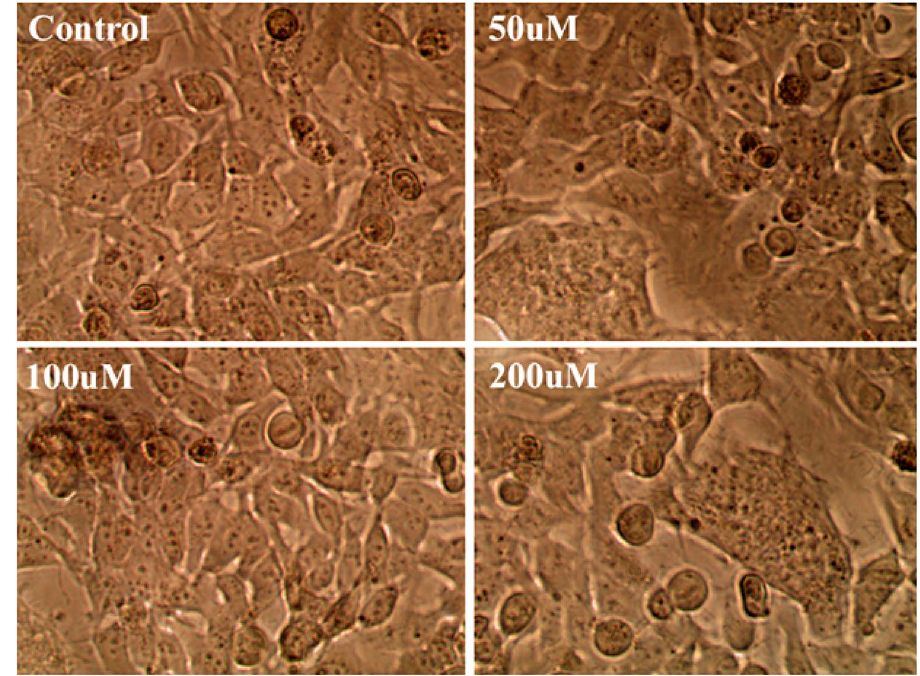
Figure 5. Vero cell viability after the treatment with different concentrations of 4,7-dichloroquinoline.